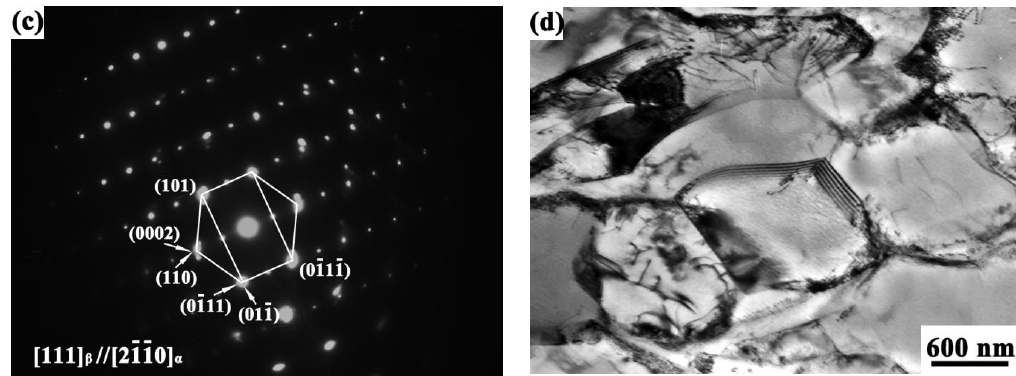
Figure 11. TEM images of Ti-6Al-4V specimens deformed at 900 °C/10 −2 s −1 : ( a ) bright field image, ( b ) dark field image, ( c ) SAED patterns, and ( d ) DRX grains.